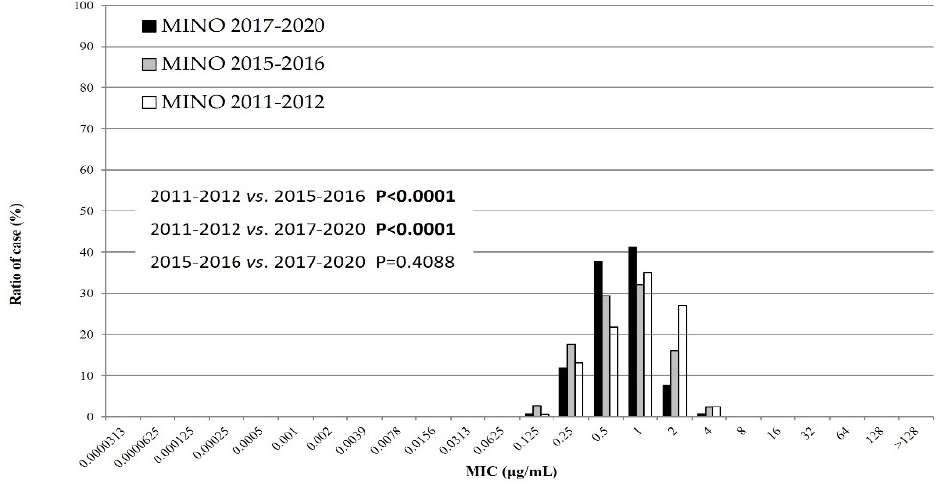
Figure 3. MIC distribution of minocycline against M. pneumoniae isolates during the three periods: